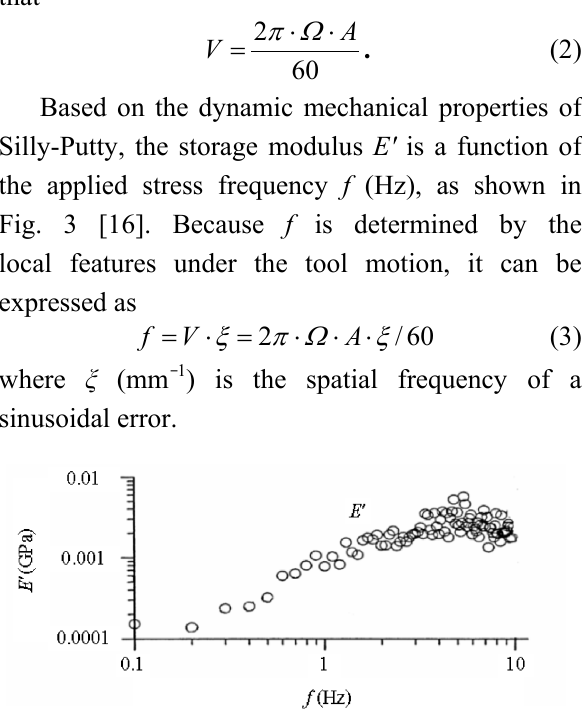
Fig. 3 Silly-putty storage modulus E′ as a function of applied stress frequency f